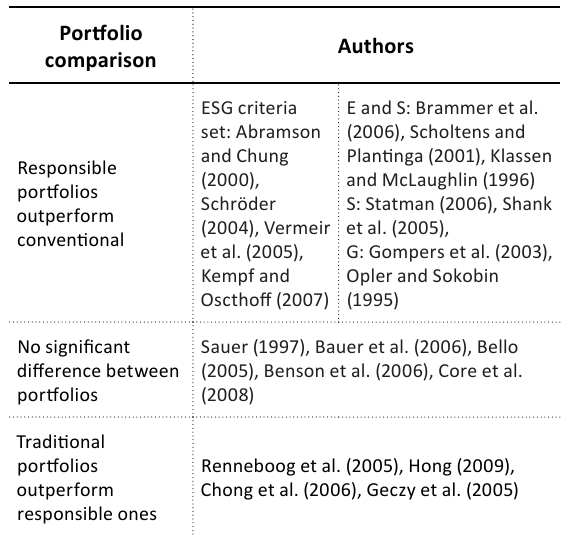
Table 1. Individual studies of responsible and conventional portfolios